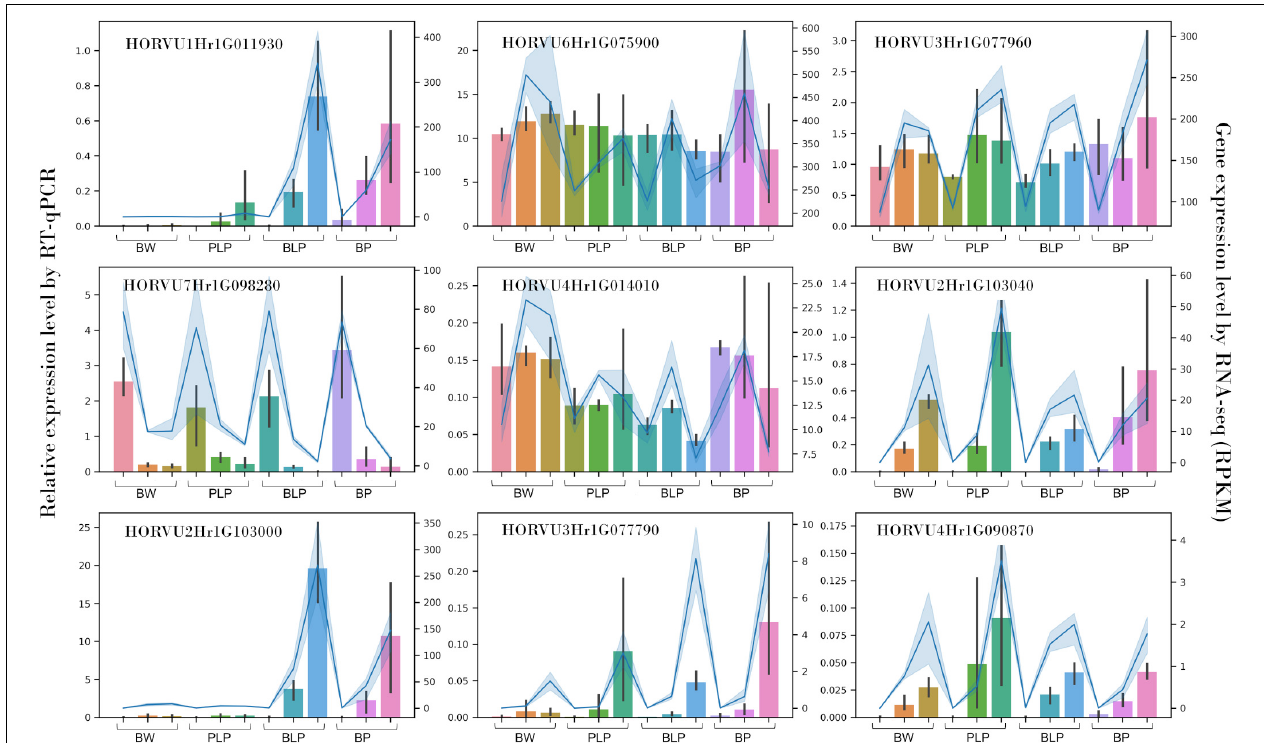
FIGURE 6 | qRT-PCR verification of nine DEGs in NILs (columns) at stages 1, 2, and 3 (left to right) and a comparison with our RNA-seq data (blue